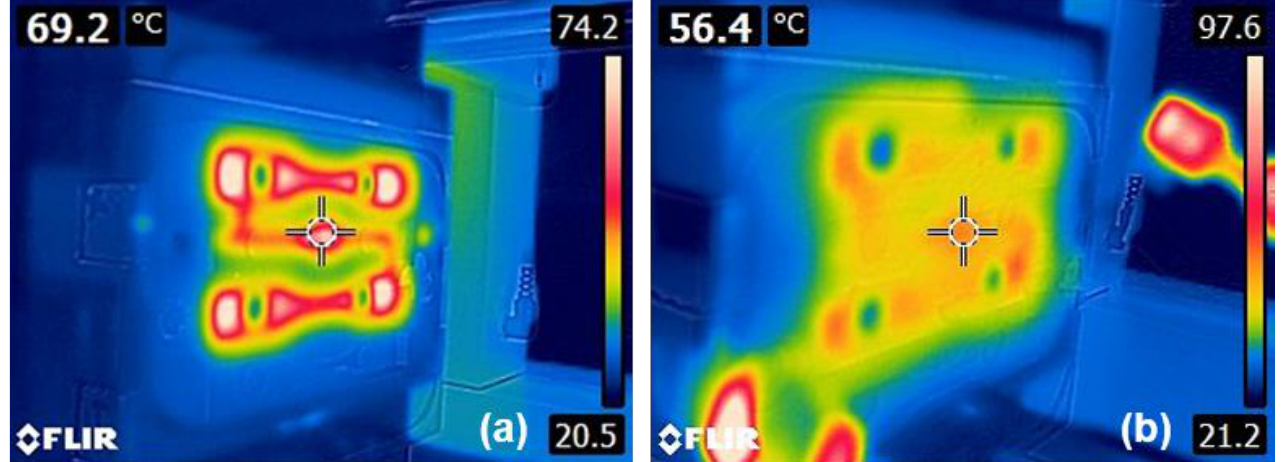
Figure 4. Temperature profiles of a ( a ) HighTemp insert and ( b ) a Rigid 10k insert.